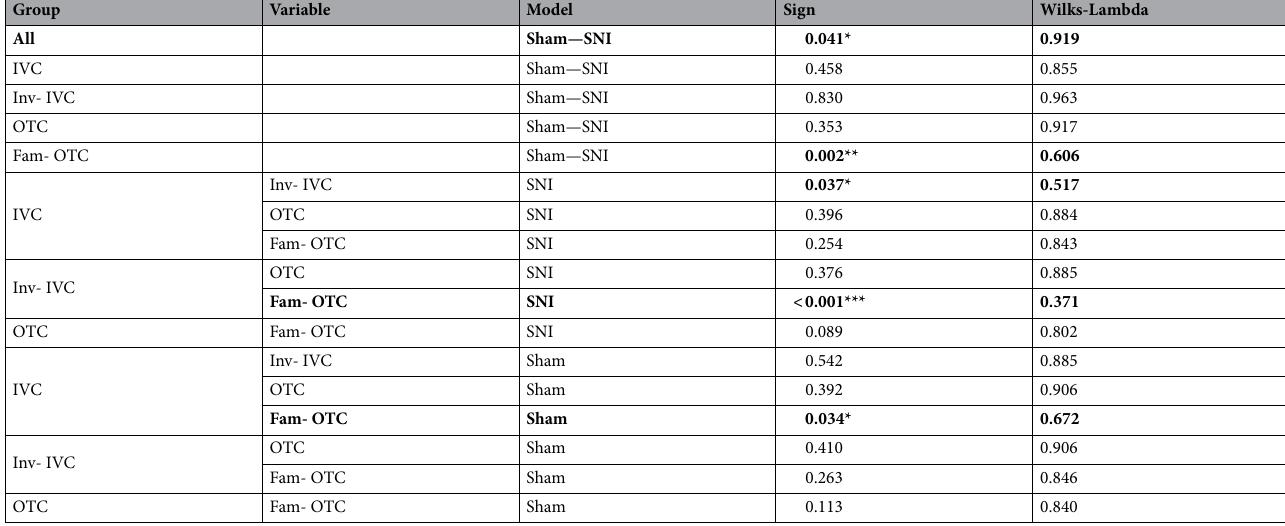
Table 2. Results of multivariate analysis of variance (MANOVA) in Fig. 2e,f. Significant values are in bold.